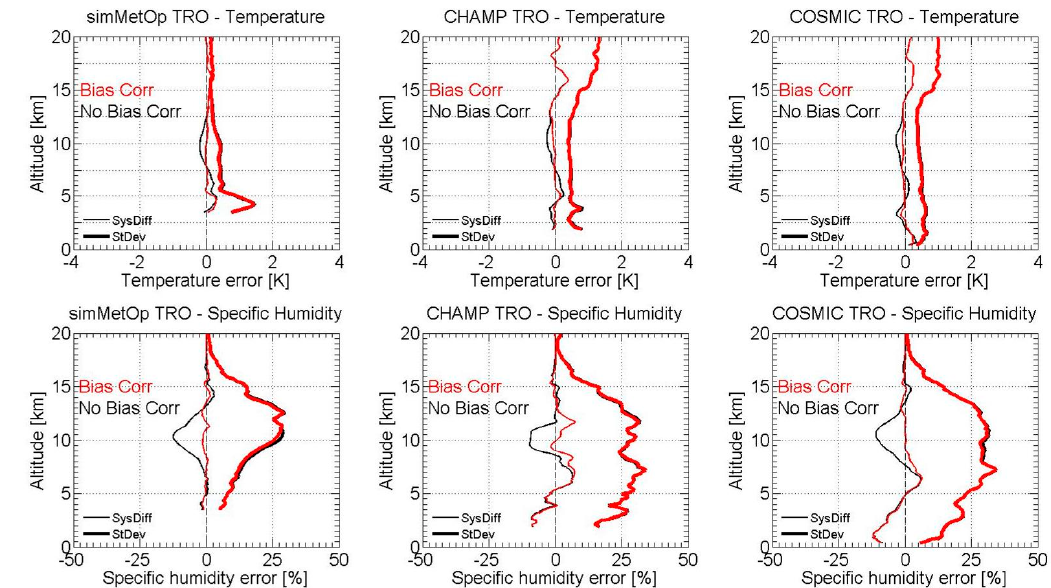
Figure A2. Systematic di ff erences and standard deviations of moist temperature and specific humidity for simulated MetOp (left), CHAMP (middle), and COSMIC (right) events in the global domain (upper two rows) and TRO regions (bottom two rows). Statistics are shown for the bias-corrected case (Bias Corr) and the no bias corrected case (No Bias Corr).